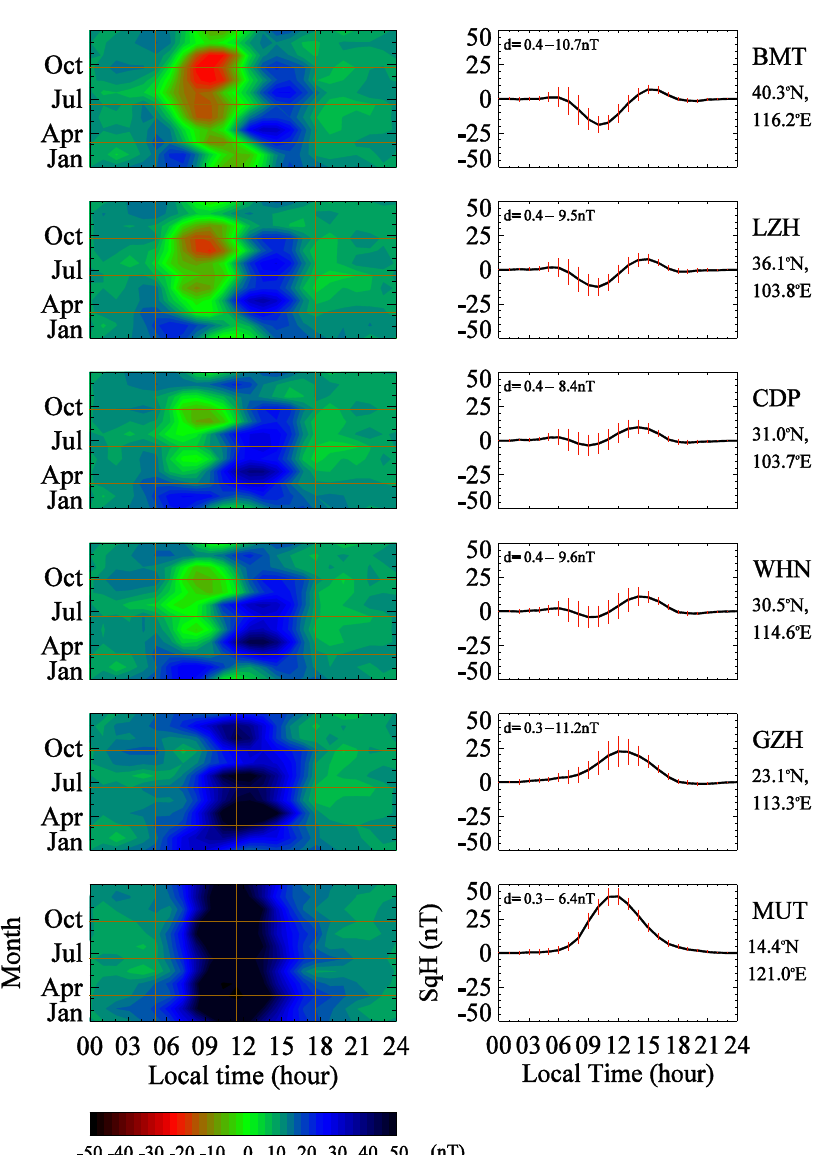
Figure 3. Diurnal variations of monthly ( left panel ), yearly ( right panel ) averaged SqH and associ- ated standard deviations d (in red short lines) at each observatory, sorted by latitude from north ( top ) to south ( bottom ) of the Sq current focus.